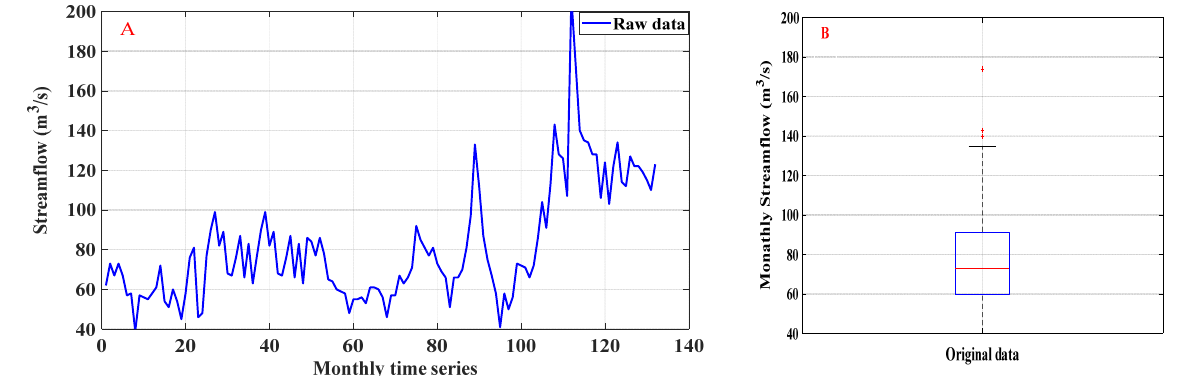
Figure 2. ( A ) Monthly streamflow time series; ( B ) box plot for the Tigris River streamflow at Amarah City.